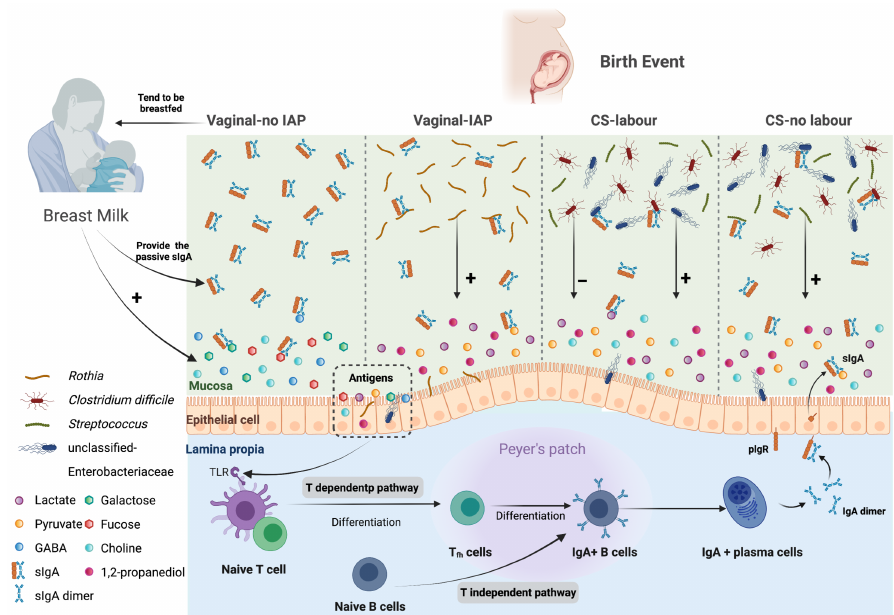
Figure 4. Putative microbe-metabolite mediated pathways from birth event to endogenous SIgA production among infants at 3 months of age, according to sequential mediation analysis, adjusted for gravida status. Compared to vaginal delivery without maternal IAP exposure, CS with labor is associated with lower level of SIgA. Infants born by vaginal delivery without IAP exposure tend to be breastfed and acquire passive SIgA, choline, GABA and lactate from breast milk. Lactate acts as the major putative microbial metabolite that stimulates endogenous SIgA production, via T cell-dependent and T cell-independent pathways. Rothia , Unclassified Enterobacteriaceae, and Streptococcus act independently or jointly with elevated lactate as the putative path for endogenous SIgA stimulation among vaginally delivered infants with IAP or those born by CS. The colonization of Clostridium difficile inhibits SIgA production by decreasing the level of